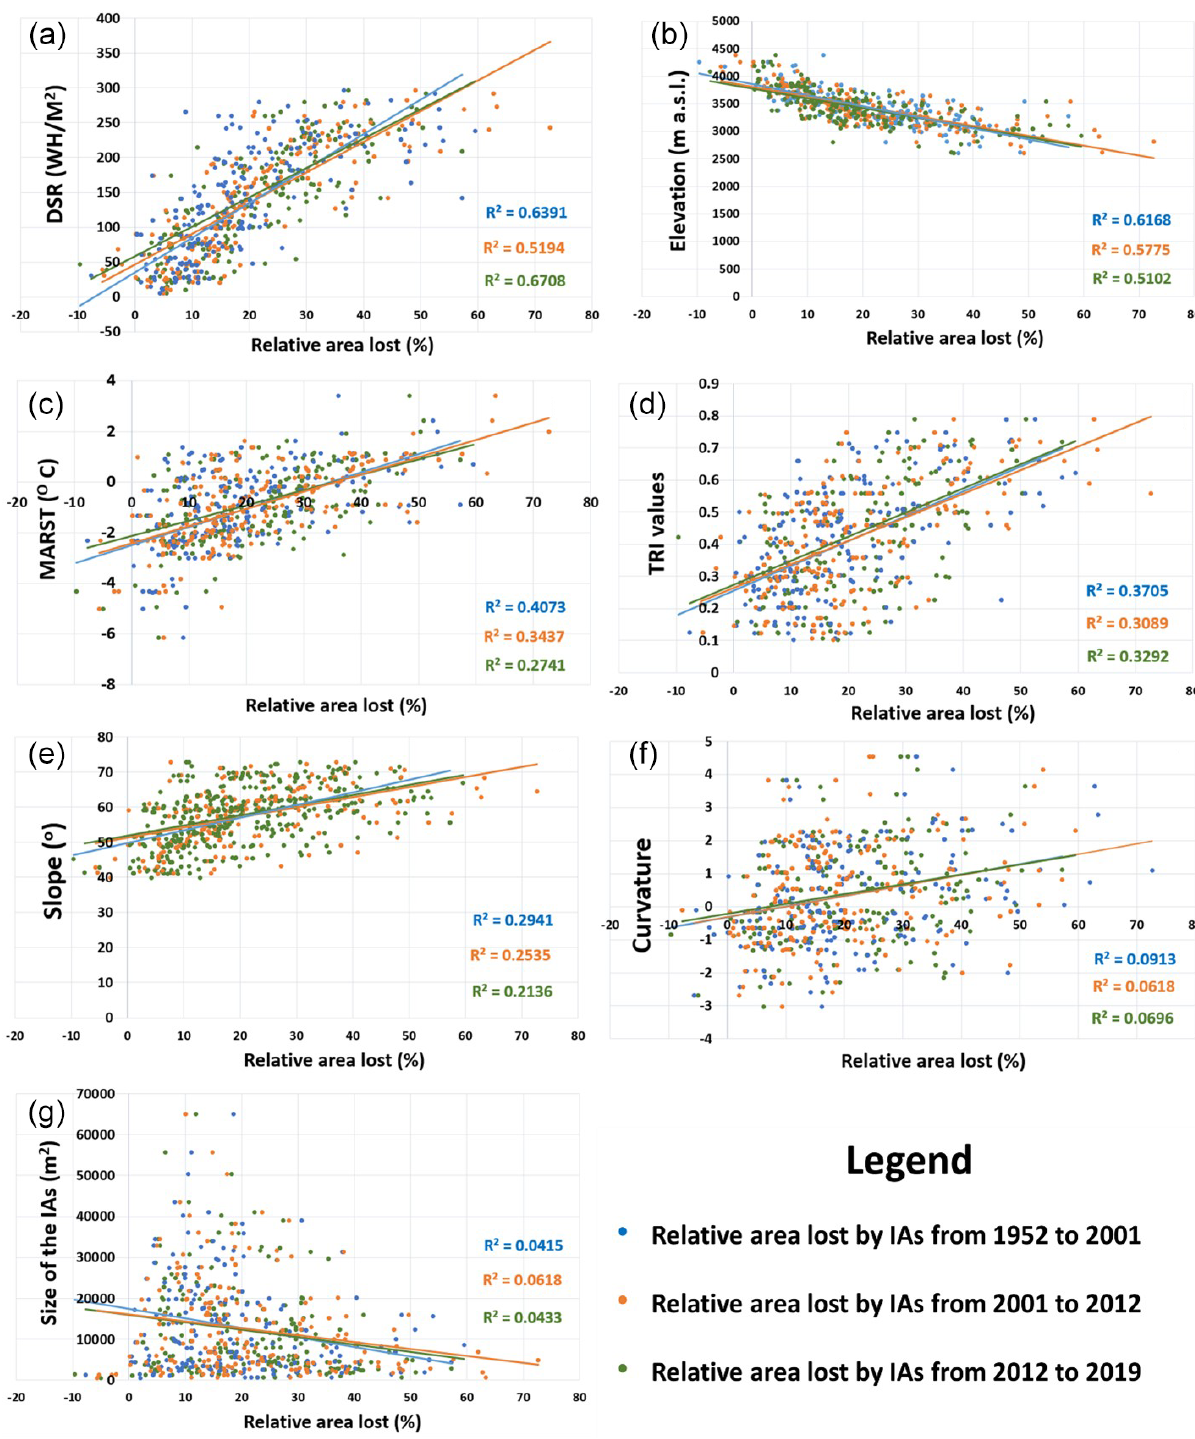
Figure 15. Scatter plots showing relationships between topographic factors and the area loss of IAs from 1952 to 2019. (a) Direct solar radiation, (b) elevation, (c) MARST, (d) TRI, (e) slope, (f) curvature and (g) size of the